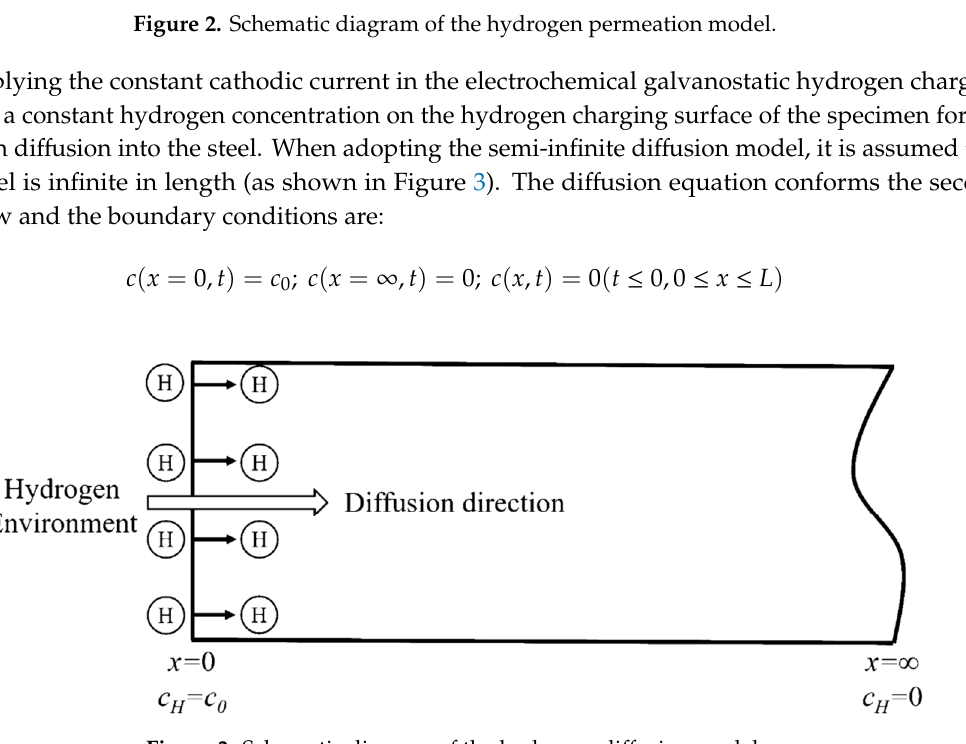
Figure 3. Schematic diagram of the hydrogen diffusion model.